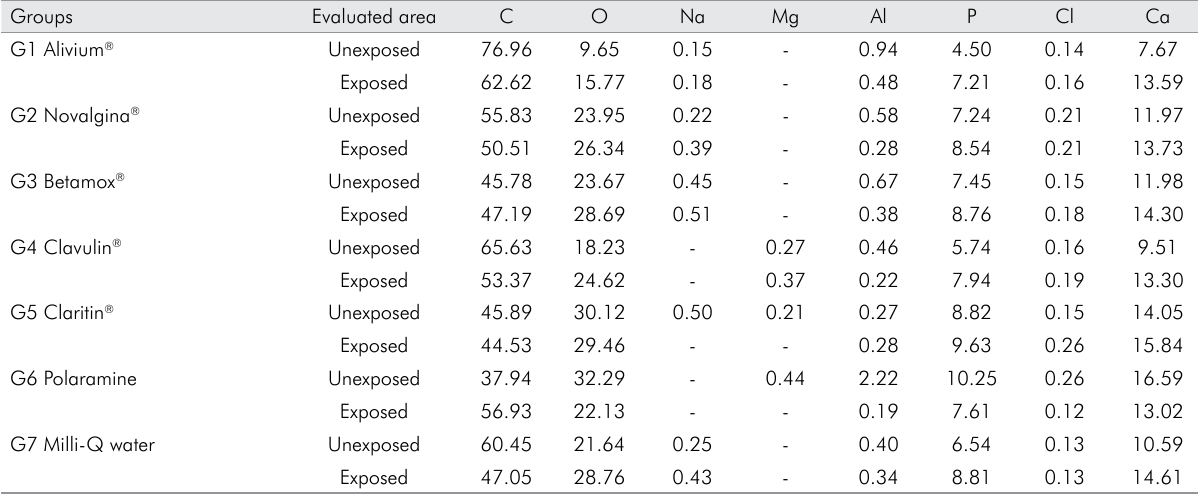
Table 3. Mean (%) of EDS analysis of surface of enamel blocks, chemical elements are shown according to the treatments and area (unexposed or exposed).